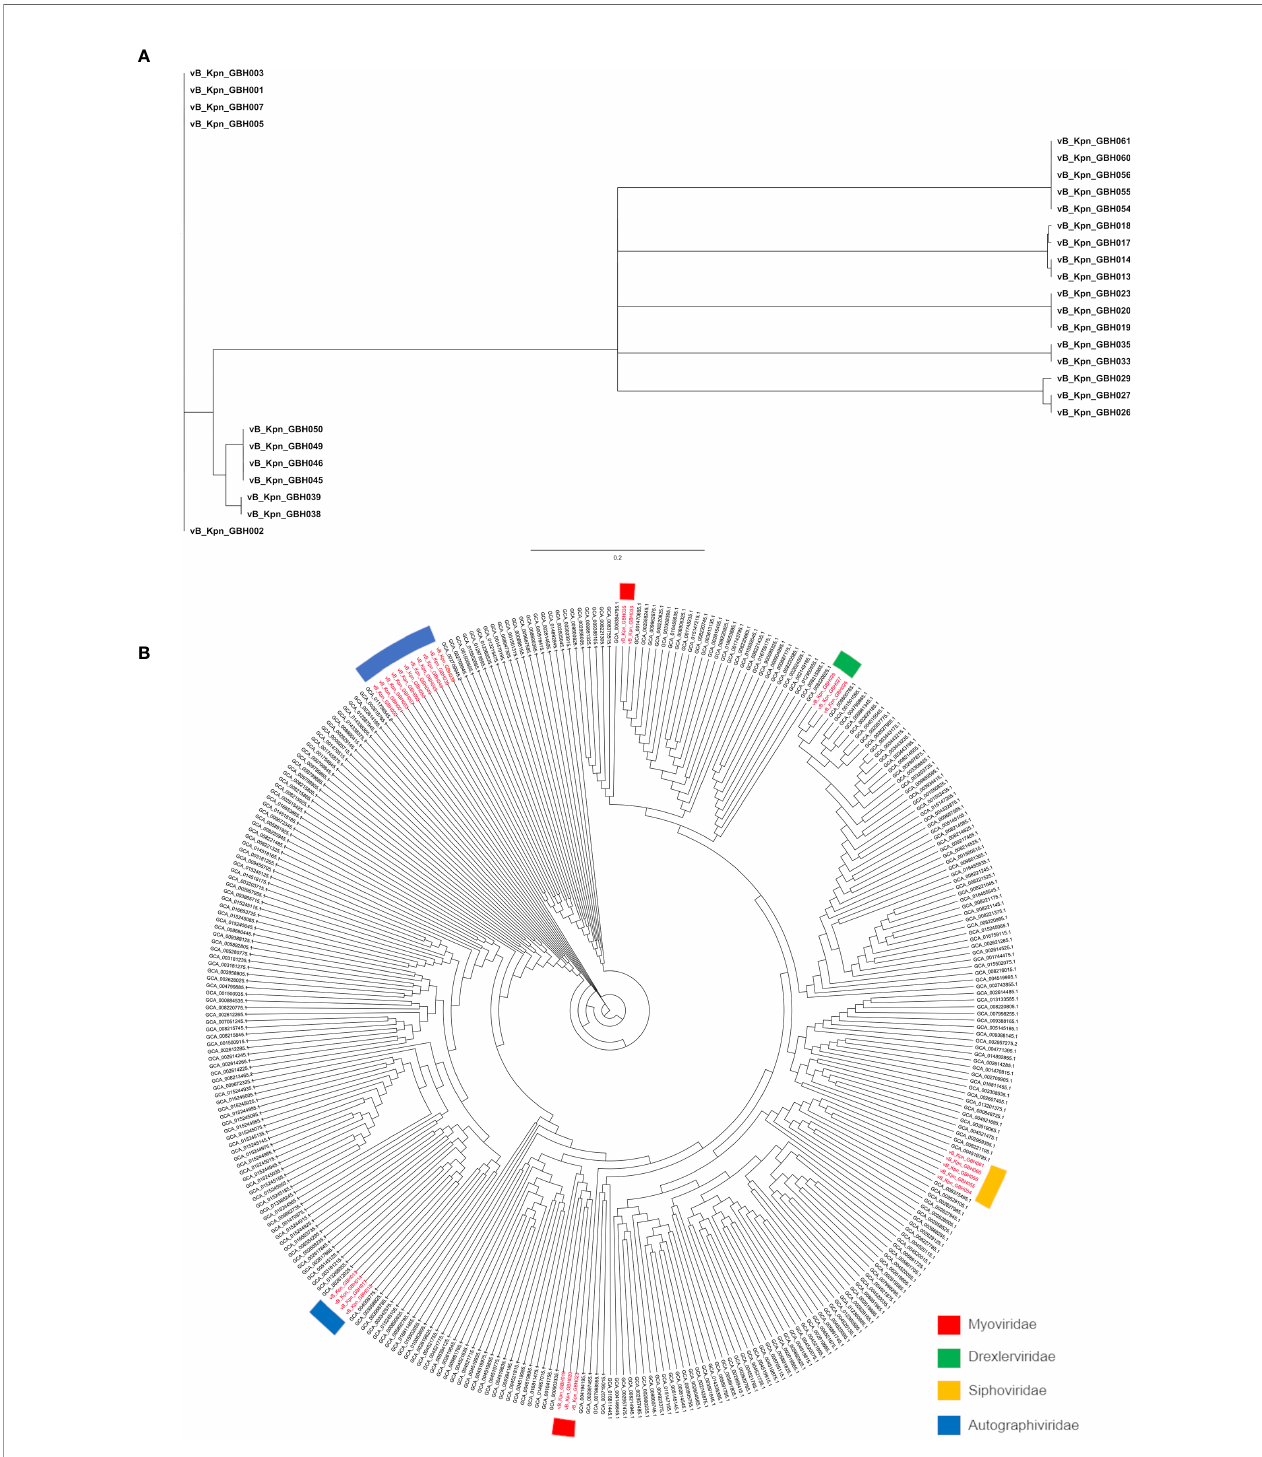
FIGURE 1 | Phylogeny of Thai K pneumoniae- selective phage. (A) MASH tree with degree of genetic similarity amongst the 28 phage genomes sequenced in this study. (B) Phylogenetic tree prepared using Archaeopteryx showing the relationship of the 28 phage genomes (in red) to 314 published Klebsiella phage